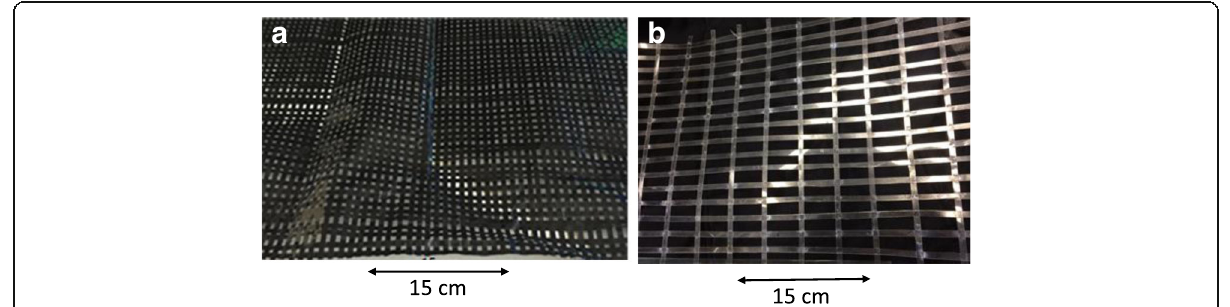
Fig. 2 The photograph of the model geosynthetics used. a Geosynthetics type I. b Geosynthetics type